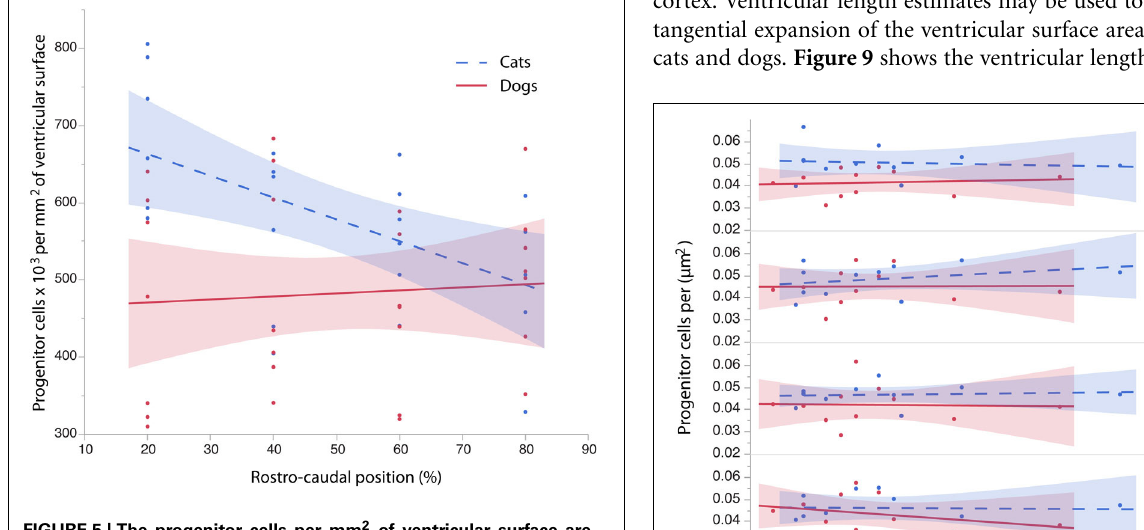
FIGURE 5 | The progenitor cells per mm 2 of ventricular surface are regressed against the rostro-caudal axis of the cortex in cats and dogs at equivalent stages of development. Progenitor cells for each selected sites were selected between ED 16 to ED 22 in cats ( = 6) and between ED 19.5 to ED 26 in dogs ( n = 6) to cover time points before the cortical plate emerges. Progenitor cells per ventricular area gradually decrease between the rostral and caudal regions in the cat whereas progenitor cells per ventricular area vary little over the rostral to caudal axis in the dog. These findings demonstrate that there are species differences in progenitor cells per ventricular area by the time layer VI-II neurons are born.